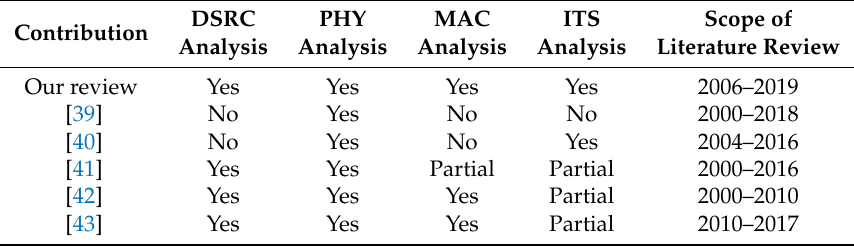
Table 1. Existing IEEE 802.11p analyses/reviews/surveys: a comparative